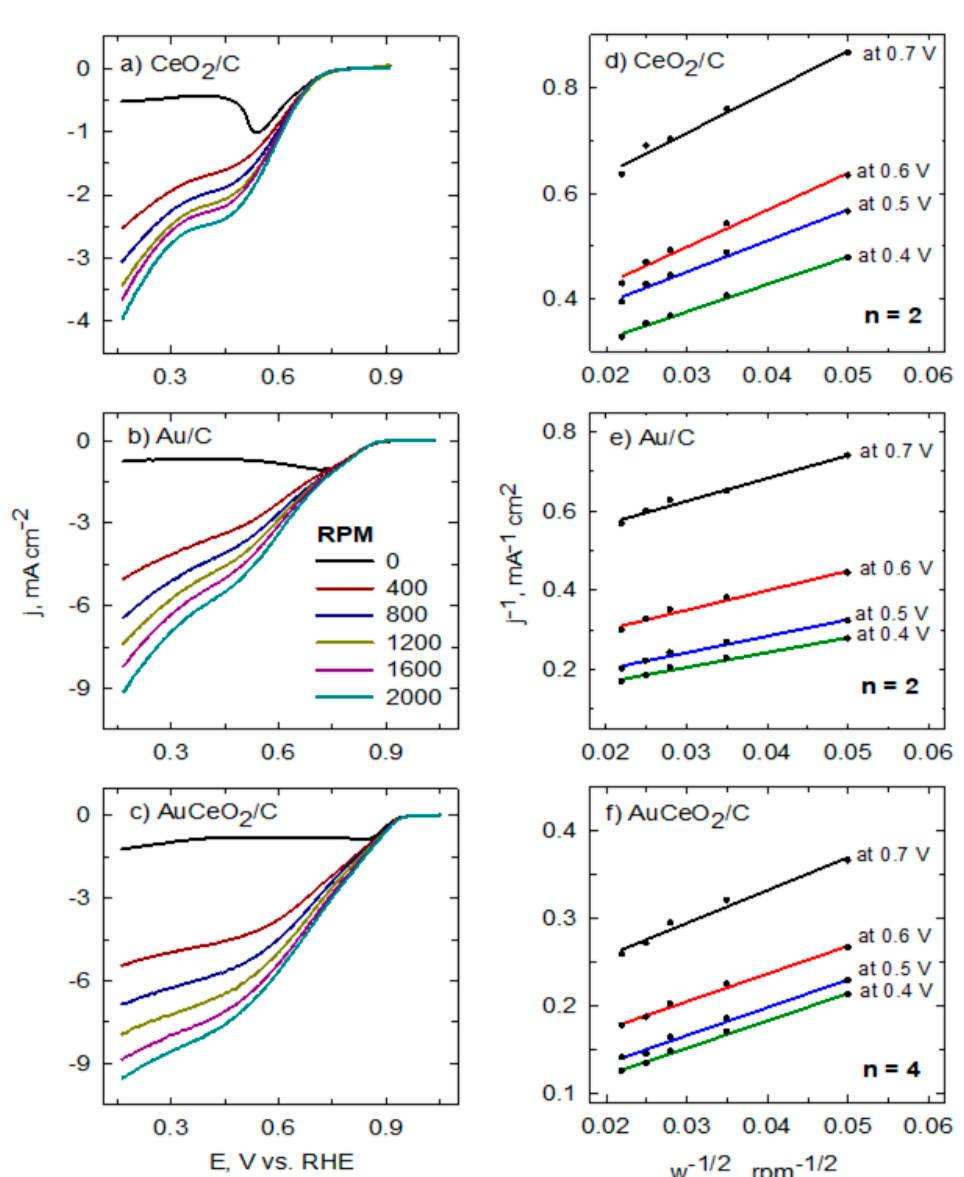
Figure 7. Linear sweep voltammetry scans ( a – c ) at the CeO 2 /C, Au/C, and AuCeO 2 /C catalysts investigated catalysts recorded in O 2 -saturated 0.1 M NaOH solution at 5 mV s –1 . Koutecky–Levich plots ( d – f ) were obtained for the investigated catalysts on different potentials in the same solution.